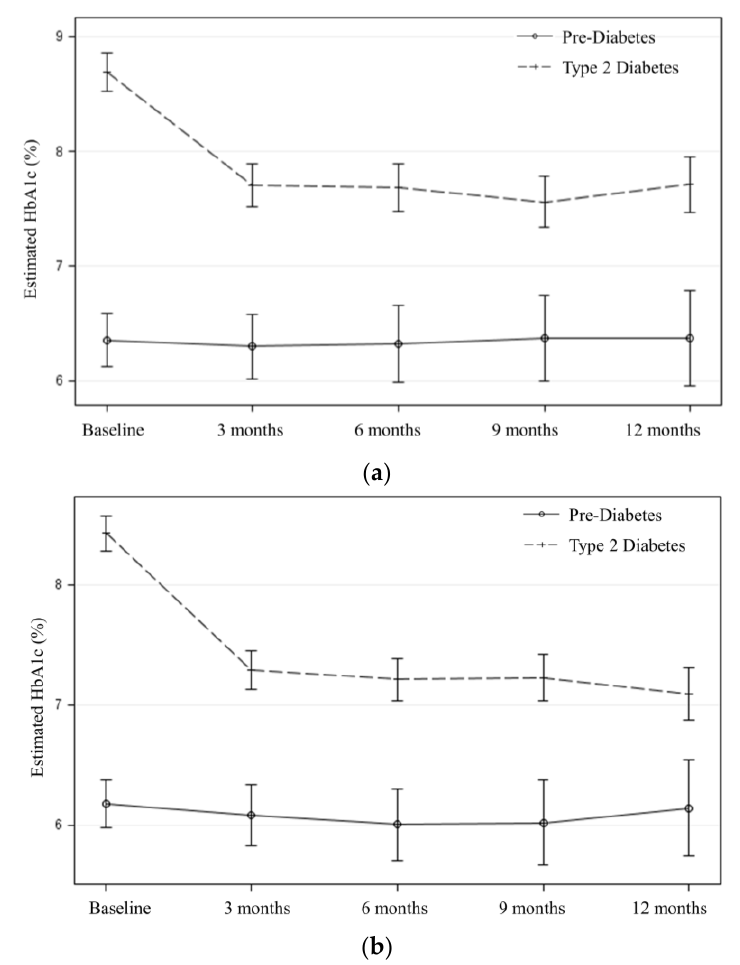
Figure 2. Estimated changes in A1c from baseline to 3, 6, 9, and 12-month follow-up after adjusting for age, gender, ethnicity, education, language, and baseline BMI category, by diabetes type and biennia: ( a ) first biennium; ( b ) second biennium. A1c, average blood glucose level over the past 3 months. BMI, body mass